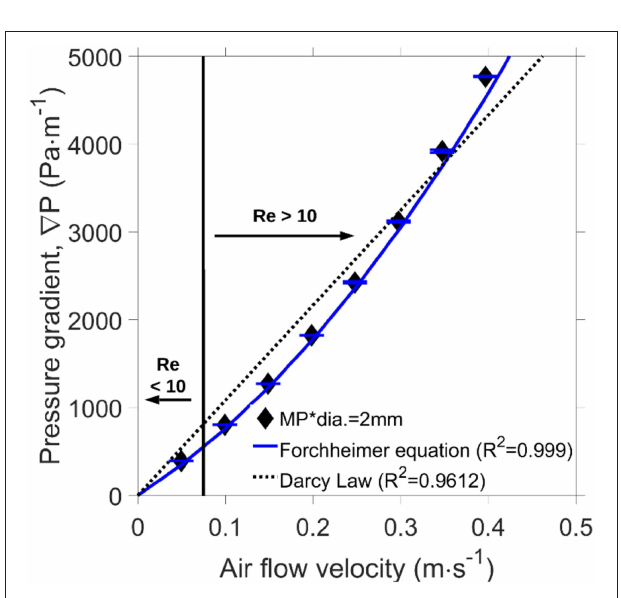
FIGURE 5 | A comparison between the Darcy law and Forchheimer equation on 2mm spherical